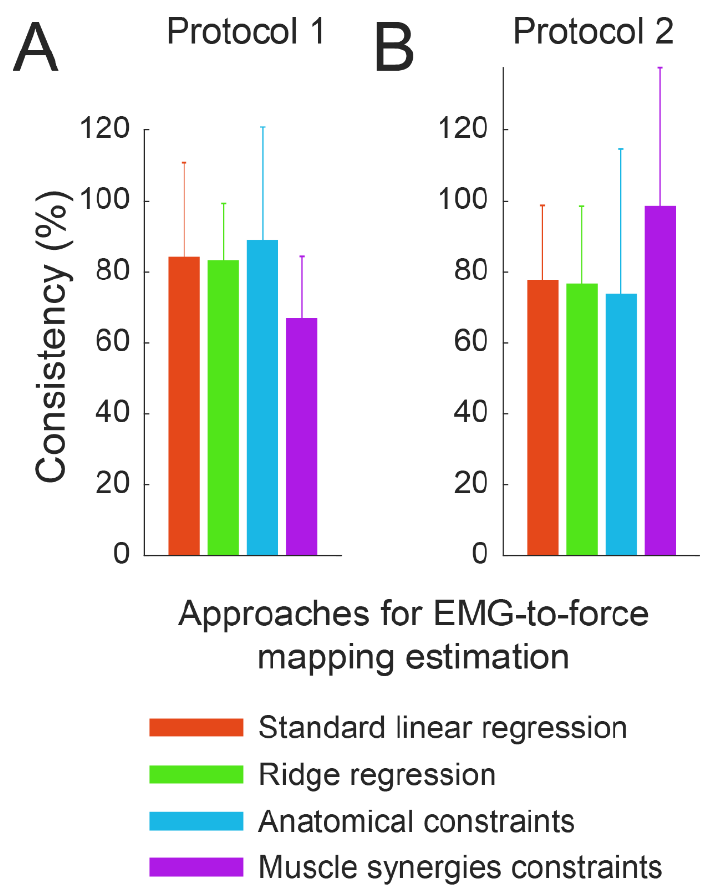
Figure 8. Consistency of the EMG-to-force mappings across sessions or conditions. The consistency of the pulling directions across sessions/conditions (mean ± SE across participants) was estimated as the difference between the pulling vectors of muscles, averaged across muscles and pairs of sessions for protocol 1 (panel A ) or only across the muscles for protocol 2 (panel B ), estimated with different approaches. Consistency is reported as a percentage of the mean between the amplitudes of the pulling vectors that were subtracted to determine it.